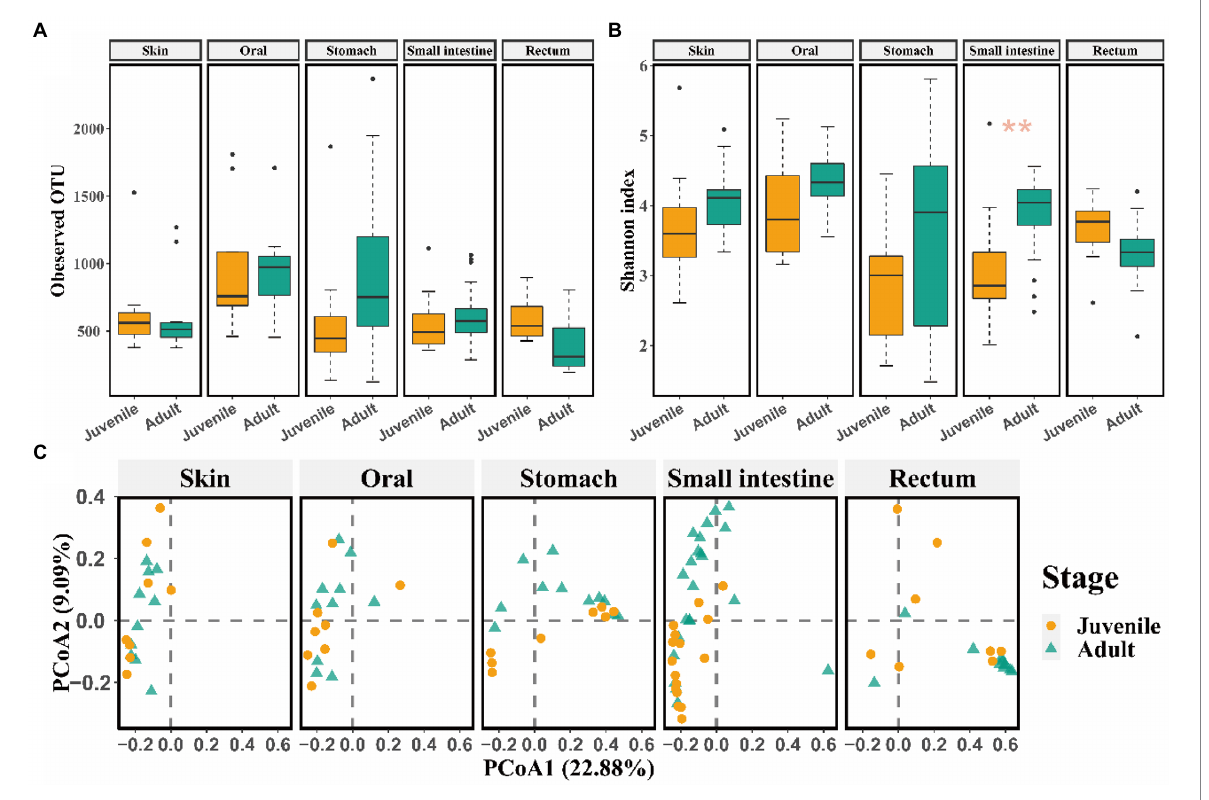
FIGURE 2 The comparison of alpha and beta diversity of symbiotic microbiota between released juvenile and adult CGSs. (A) Boxplot of observed OTU values; (B) Boxplot of Shannon diversity values. Data are presented as means ± SE, and significant differences are marked with an asterisk; (C) PCoA scatter plots present the dissimilarity of microbiomes at the OTU level based on Bray-Curtis